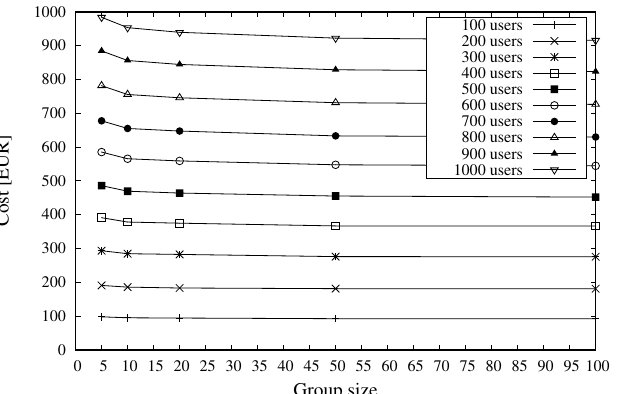
Figure 14. The daily cost profile of the community versus the group size, for different values of the number of users in the